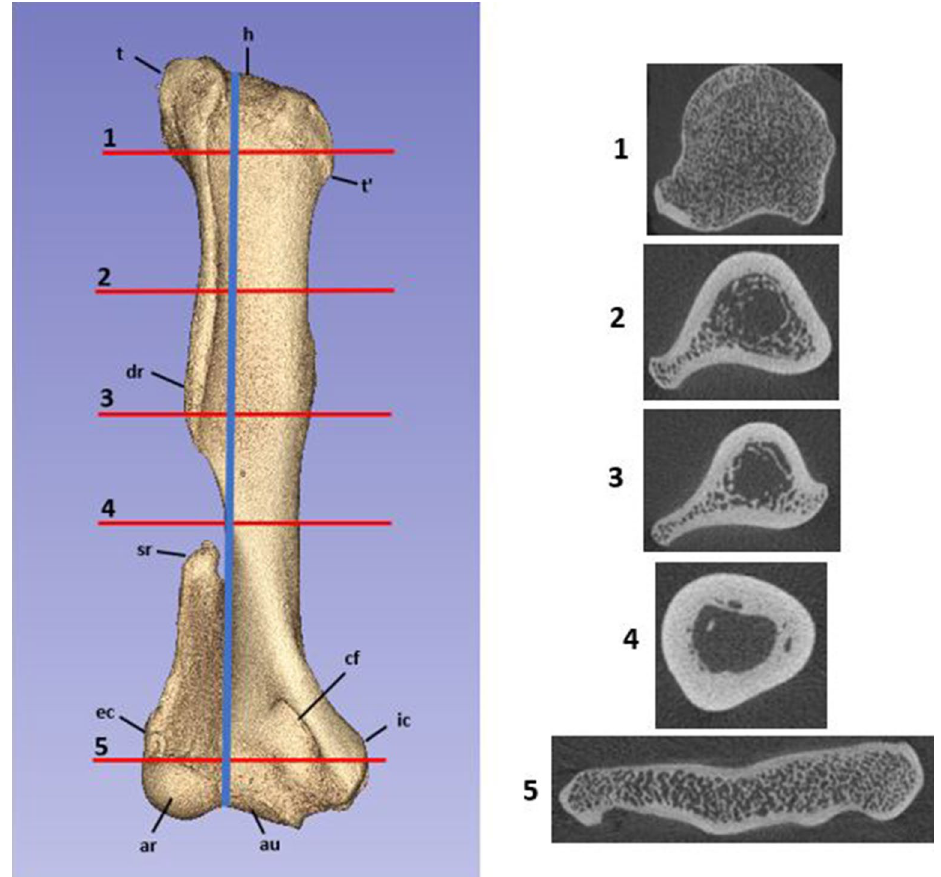
Figure 2. Cranial view of the koala humerus produced by 3D reconstruction of the micro-CT scan using Slicer version 4.10.2. Left of the image is lateral. Blue line indicates humeral length. Red lines indicate each measurement level of the humerus. 1 = between tuberosities; 2 = proximal third; 3 = deltoid ridge; 4 = distal third; 5 = between epicondyles. Identifying landmarks are also identified. Where h = humeral head; t = greater tuberosity; t’ = lesser tuberosity; dr = deltoid ridge; sr = supinator ridge; cf = supracondylar foramen; ec = external epicondyle; ic = internal epicondyle; ar = articular surface (radius); au = articular surface (ulna). Also included are the transverse slices of each measurement level with lateral on the left and cranial at the bottom of each